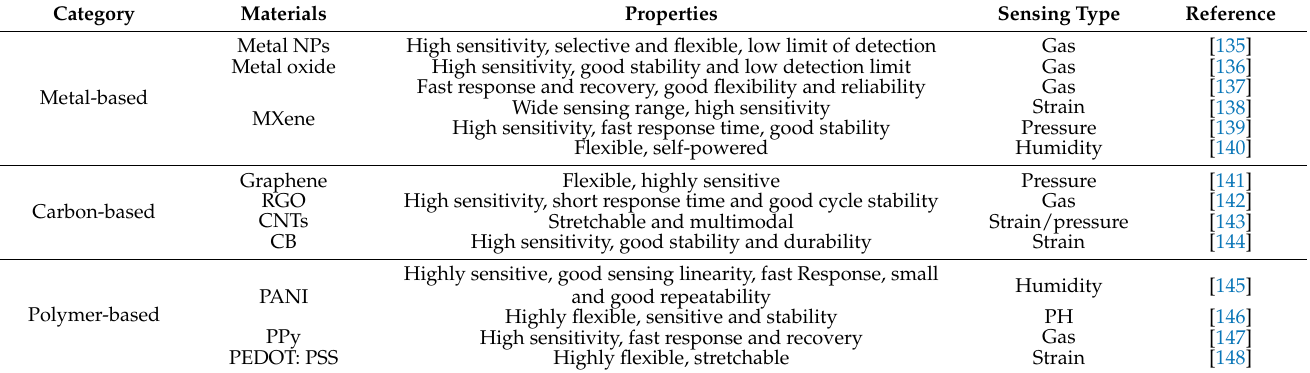
Table 2. Examples of sensing applications of electrospun conductive